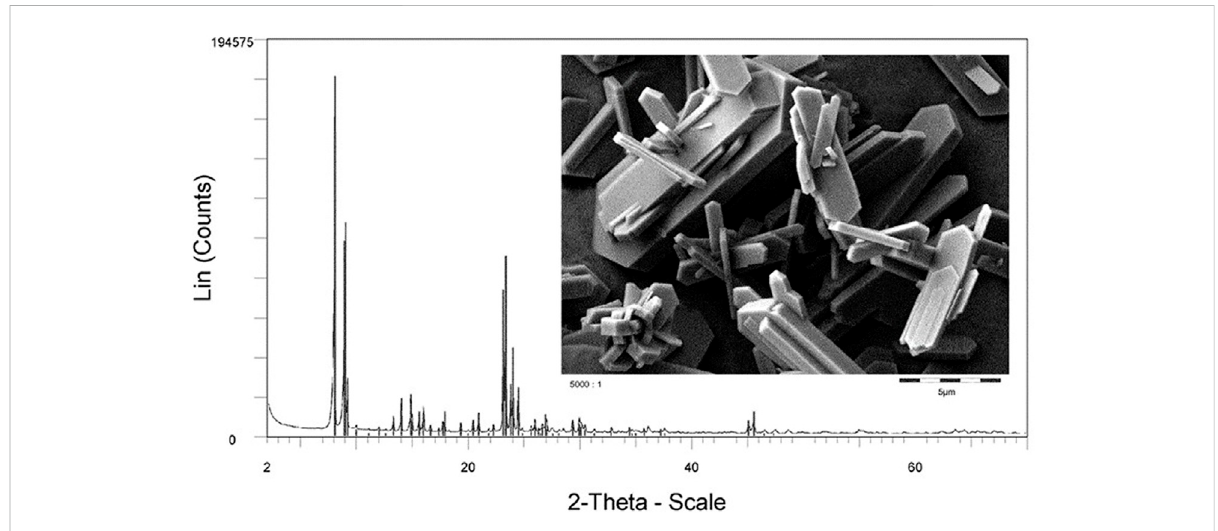
FIGURE 2 Silicalite from elemental